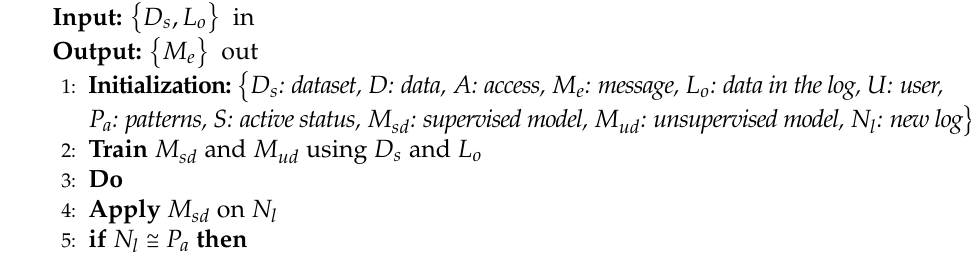
Algorithm 3: Intrusion detection